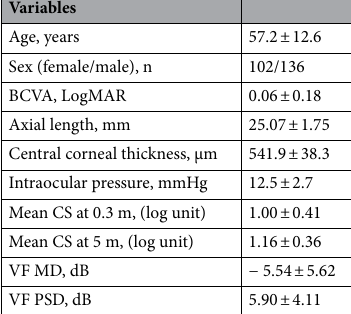
Superior hemifield defect,